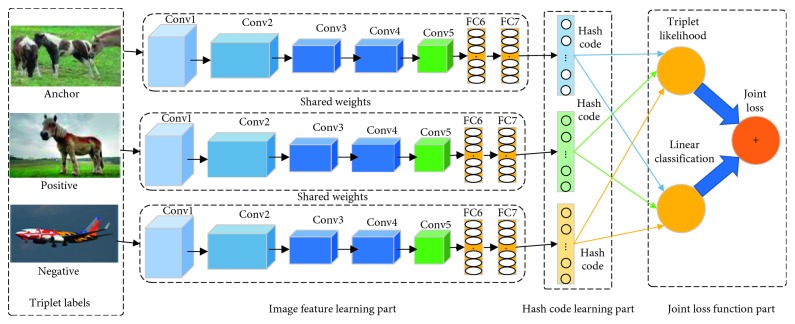
Framework of JLTDH.